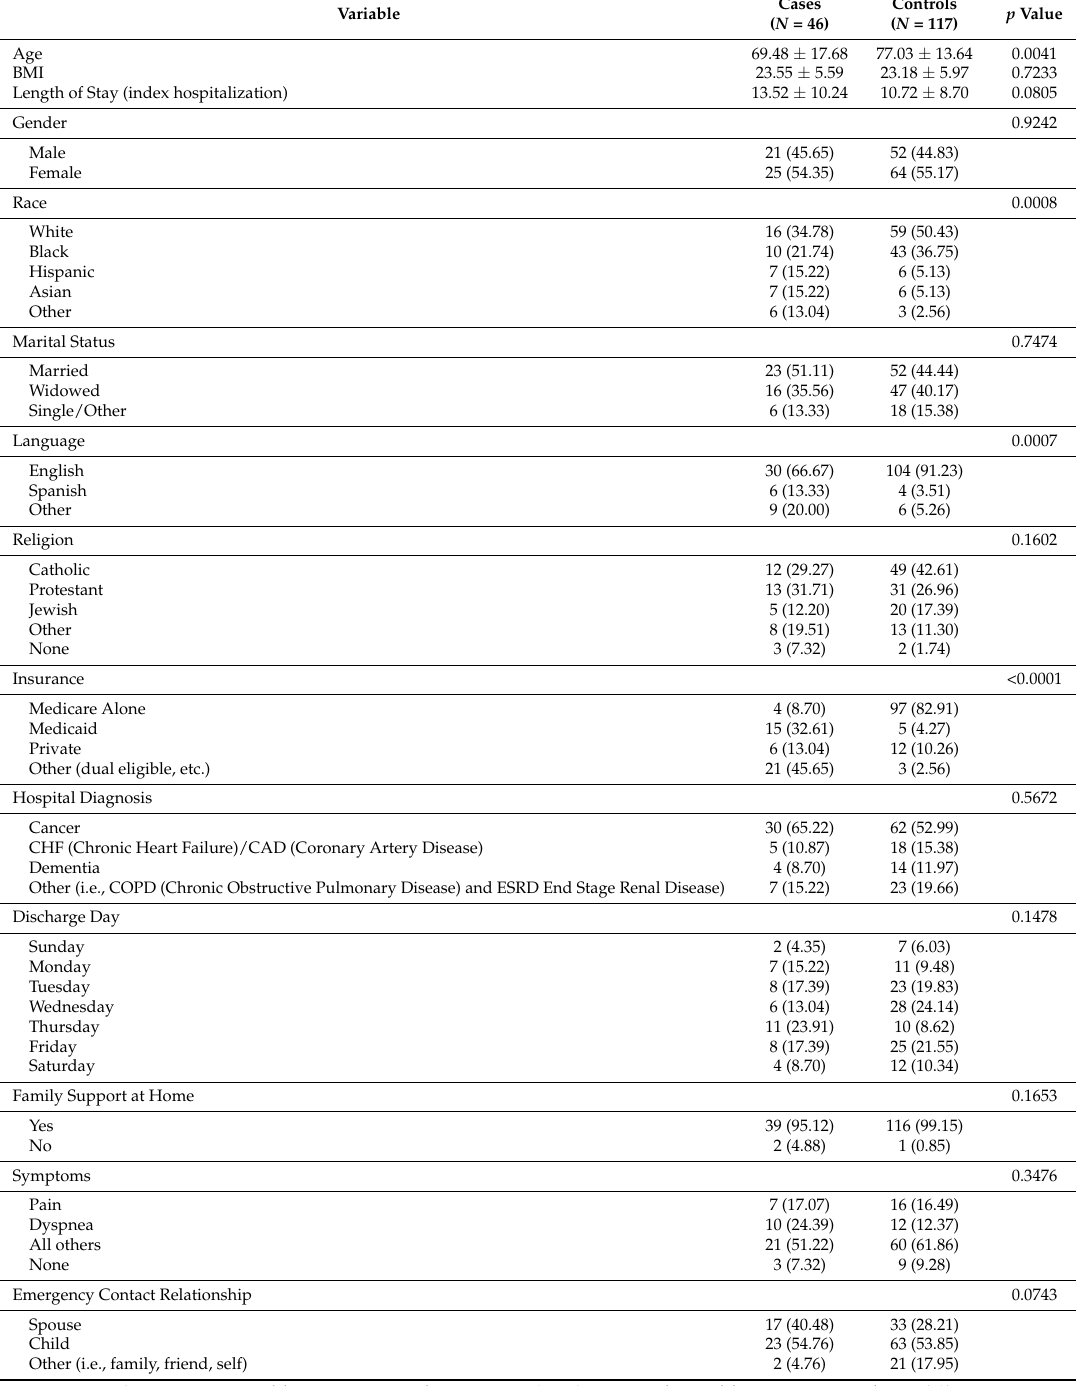
Table 1. Comparison of Patient Characteristics ( N = 163). BMI: body mass